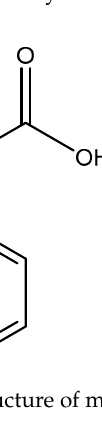
Figure 6. Illustrated structure of the magnesium bis -mandalate dihydrate structure proposed by Schmidbaur et al. [91].